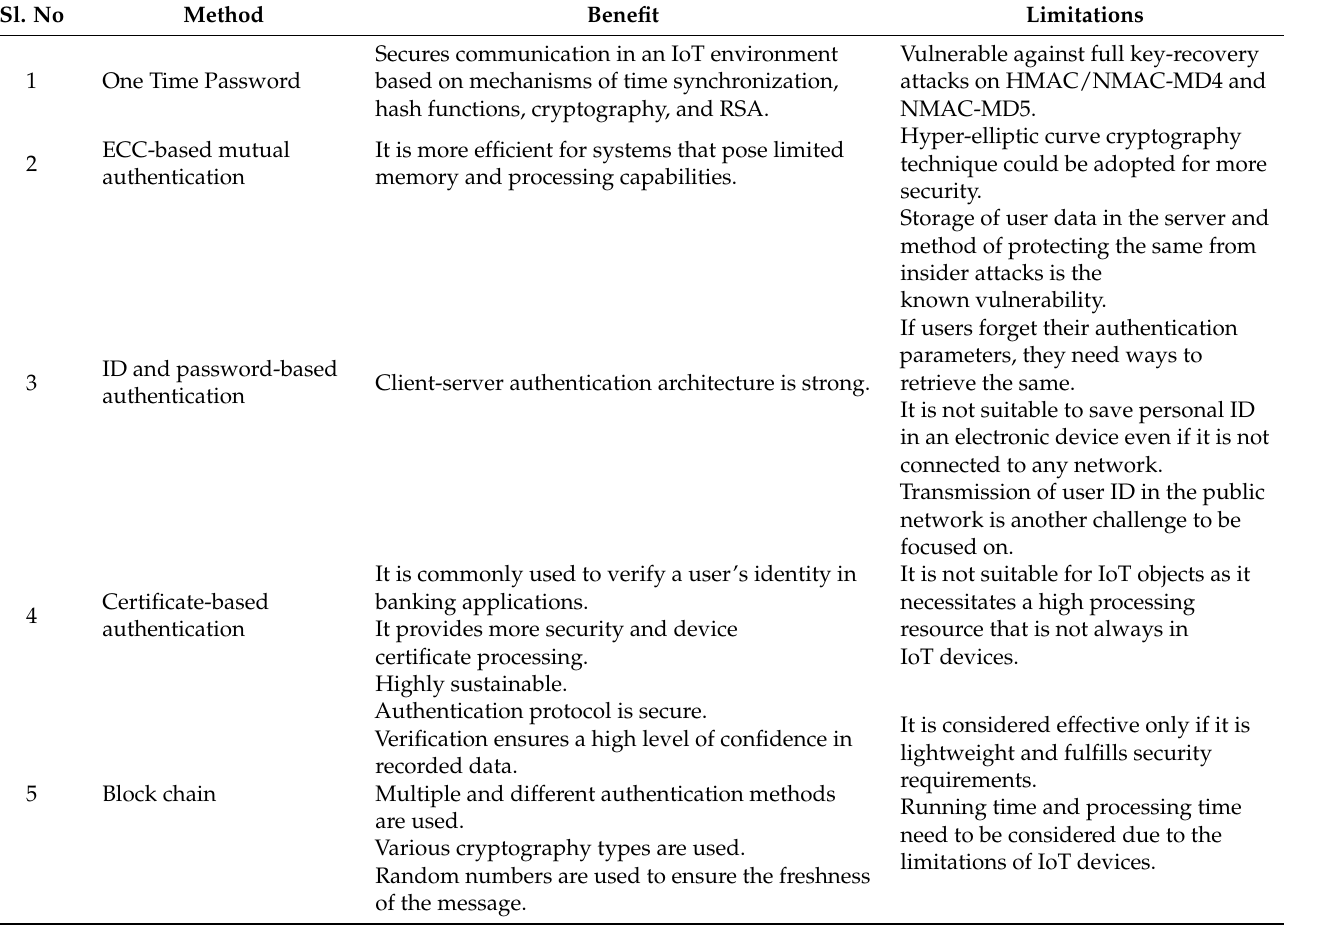
Table 1. Summary of Authentication Techniques for securing IoT